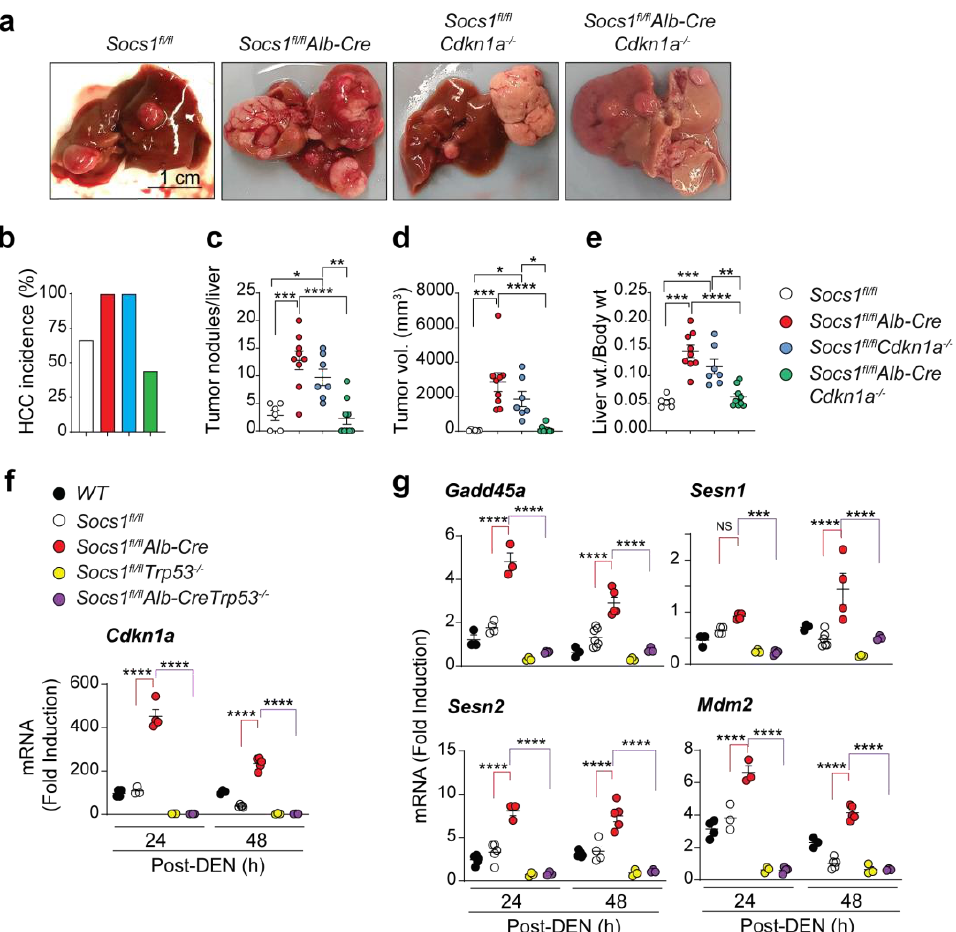
Figure 1. Increased HCC susceptibility of SOCS1-deficient mice requires CDKN1A induced by p53. ( a ) Two weeks-old mice of the indicated genotypes were treated with DEN (25 mg/kg bodyweight). HCC development was evaluated 10 months later. ( a ) Macroscopic liver images from representative mice for each genotype are shown (n = 5 – 8 mice/group). Additional data are shown in Supplementary Figure S1. ( b – e ) Cumulative data on HCC incidence ( b ), the number of visible tumors per liver ( c ), tumor volume (sum of all tumors ≥ 2 mm in diameter; ( d ) and the liver to bodyweight ratio € . ( f , g ) Eight weeks-old mice (n = 3 – 6/group) were treated with DEN (100 mg/kg bodyweight). After 24 h and 48 h, induction of Cdkn1a ( f ) and the indicated p53 target genes ( g ) in the liver was evaluated by RT-qPCR. Mean ± SE; One-way ( c – e ) or two-way ( f , g ) ANOVA with Tukey’s multiple comparison tests: * p < 0.05, ** p < 0.01, *** p < 0.001, **** p < 0.0001; NS, not significant. The statistical differences are indicated to highlight the comparisons between control, SOCS1 knockout, and SOCS1p53 double knockout